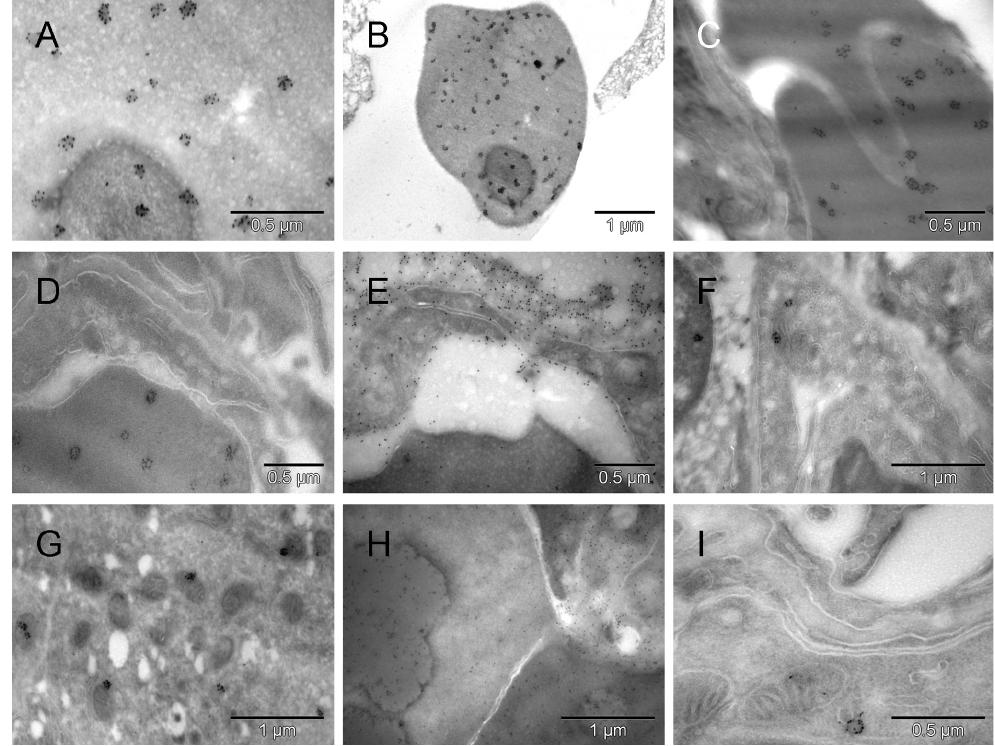
Figure 8. Calmyrite: a new ultrastructural entity involved in anaerobic metabolism. Uneven distribution of the abundant calmyrin- specific label in erythrosomes from the solid tissue under the hyaline membrane was striking [ A , B , C & D ]. No such clusters were seen extracellularly [ E ]. The gold particles appeared arranged with certain symmetry in clusters of about 6 to 12, as if the protein became a part of distinct para-crystalline ultrastructures that in less differentiated regions were not formed ([ E ] and Figure 6 & Figure S6). Such gold grain clusters were also present in ECs [ F ] and tumor cells [ G ] where small dark mitochondria suggested hypoxic distress. In a giant cell the uneven distribution of scattered calmyrin-specific label and heterogeneity of electron density indicated an ongoing process of erythrogenic conversion [ H ]. One calmyrite in a section from normal rat lung is shown in [ I ]. Those ultrastructural para-crystalline elements visualized by calmyrin-specific label are being described here for the first time and referred to as